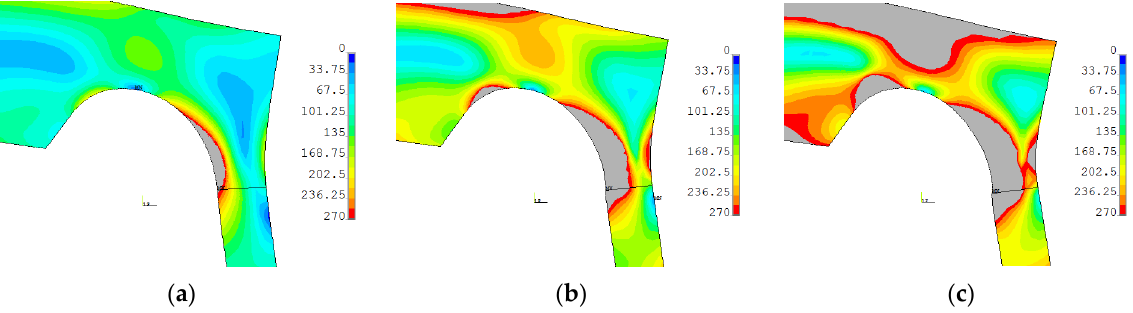
Figure 17. Equivalent von Mises stress in optimal SRG with mean dimensions, material 2P for: ( a ) cycle 6–22 MPa; ( b ) cycle 14–35 MPa; ( c ) cycle 26–41 MPa. Areas in which yield limit (270 MPa) has been exceeded are marked with gray color.